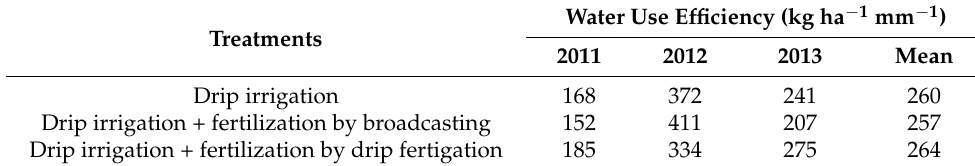
Table 9. Irrigation water use efficiency in the years 2011–2013.